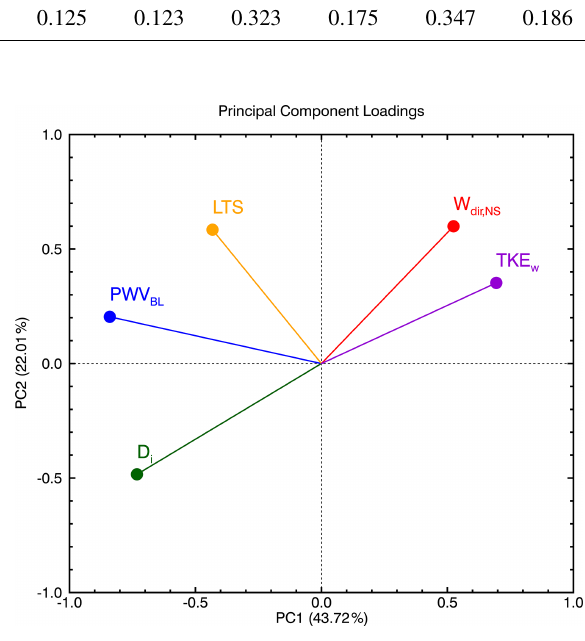
Figure 4. The projections of TKE w (purple), W dir , NS (red), LTS (orange), PWV BL (blue), and D i (green) onto the first principal component (PC1) and the second principal component (PC2). The x coordinates denote variables’ correlations with PC1, and the y co- ordinates denote variables’ correlations with